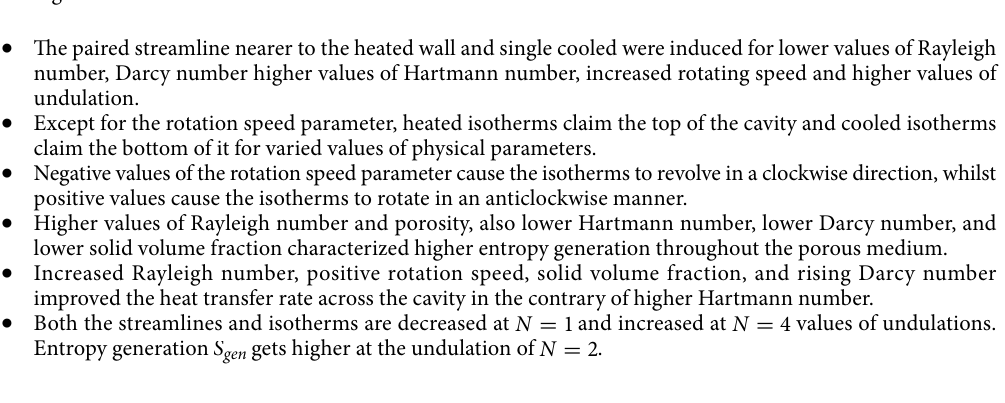
Figure 10. Variations of Nu avg with Ha for various φ at Ra 0.4, and ( c ) ε ( b ) ε =